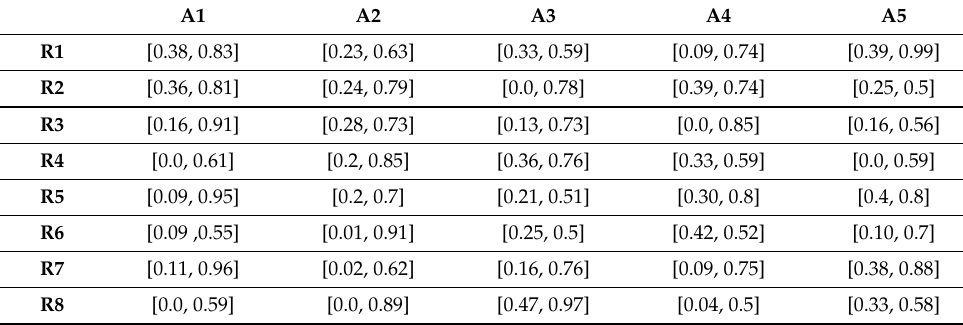
Table 6. Survival time payoffs for the defender in Case Study-3.